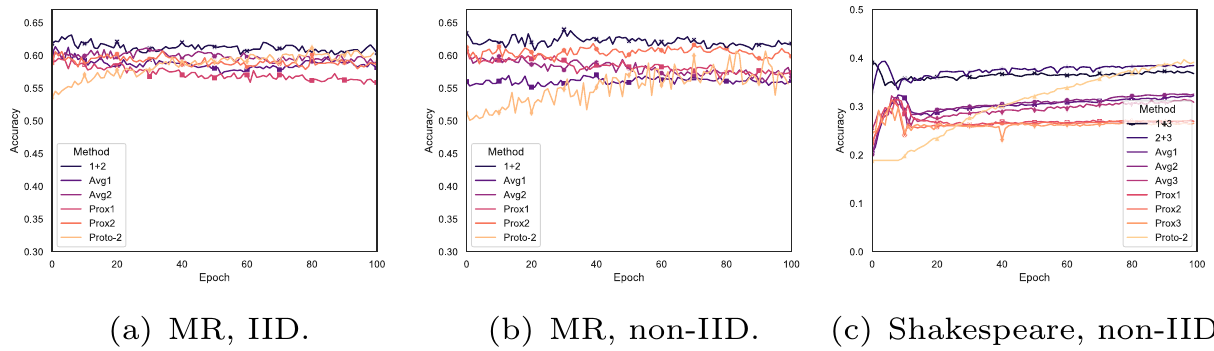
Fig. 5 Two-level heterogeneity performance comparisons of text datasets under IID and non-IID